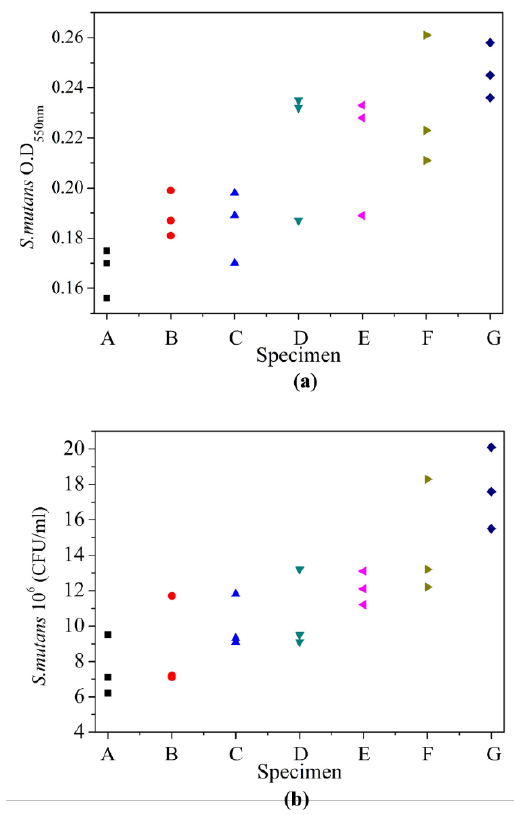
Figure 10. Streptococcus mutans bacterial amount of the present specimen A – G, revealing